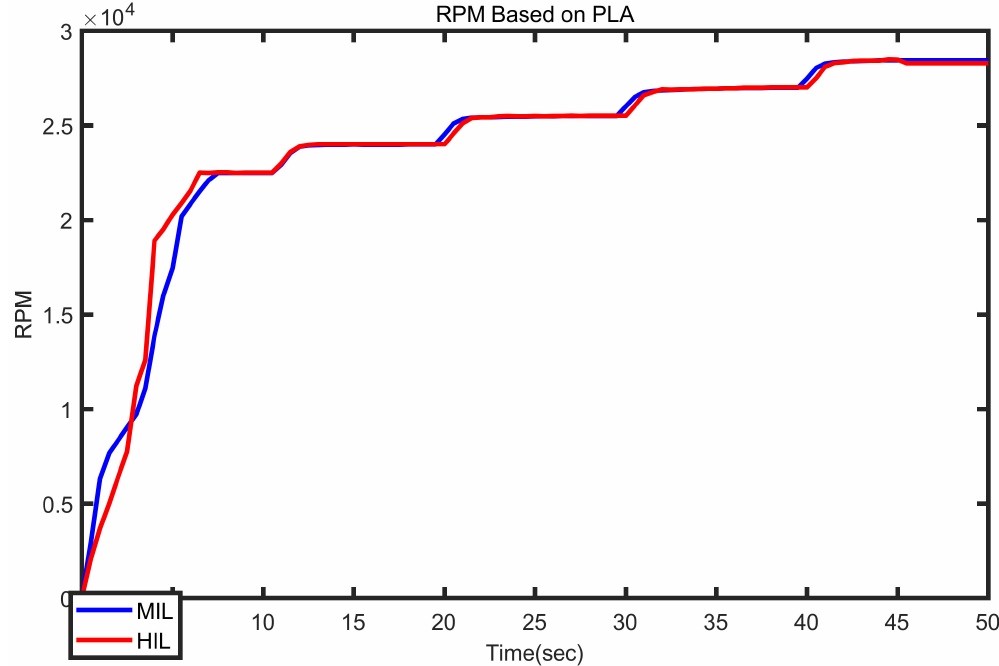
Figure 20. MIL and HIL RPM signal comparison for MIN–MAX controller.